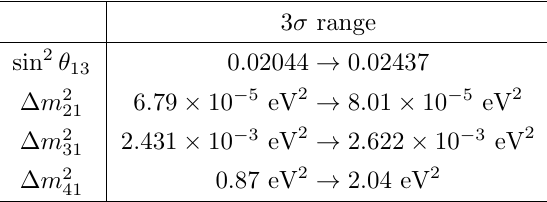
Table 3 . The mixing observables which are used to evaluate the model parameters (cid:20) s , (cid:20) a , m and m s . The 3 (cid:27) ranges of sin 2 (cid:18) 13 , (cid:1) m 2 from ref. [74].